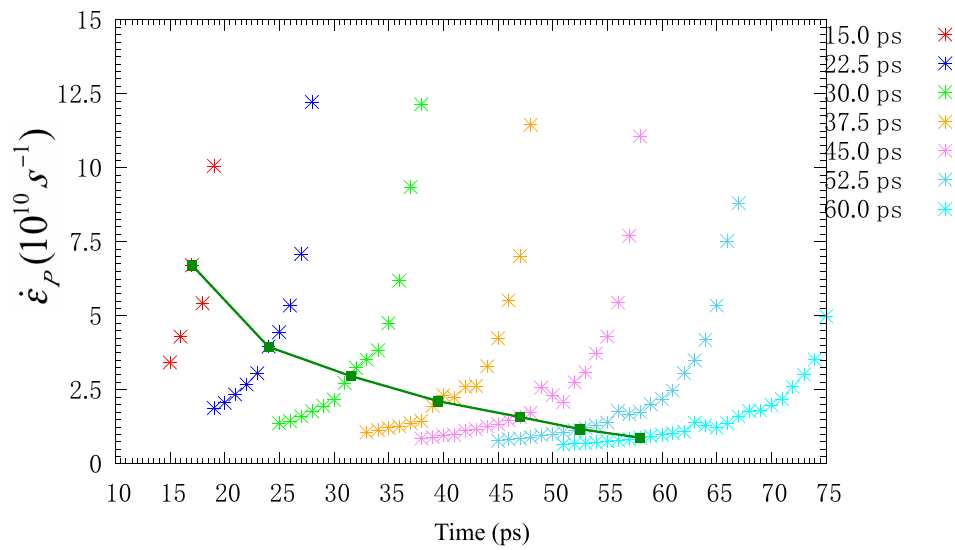
Figure 8. Time evolution of the plastic strain rate (stars) during ramp wave propagation through the sample with the critical plastic strain rate, 𝜀̇ 𝑃𝑐 , (forest-green line) evaluated at the beginning of the hcp phase nucleation behind the compression front, once the ramp wave has steepened into a shock. The bcc-to-hcp phase transition is triggered in scenario (ii) whenever the plastic strain rate, 𝜀̇